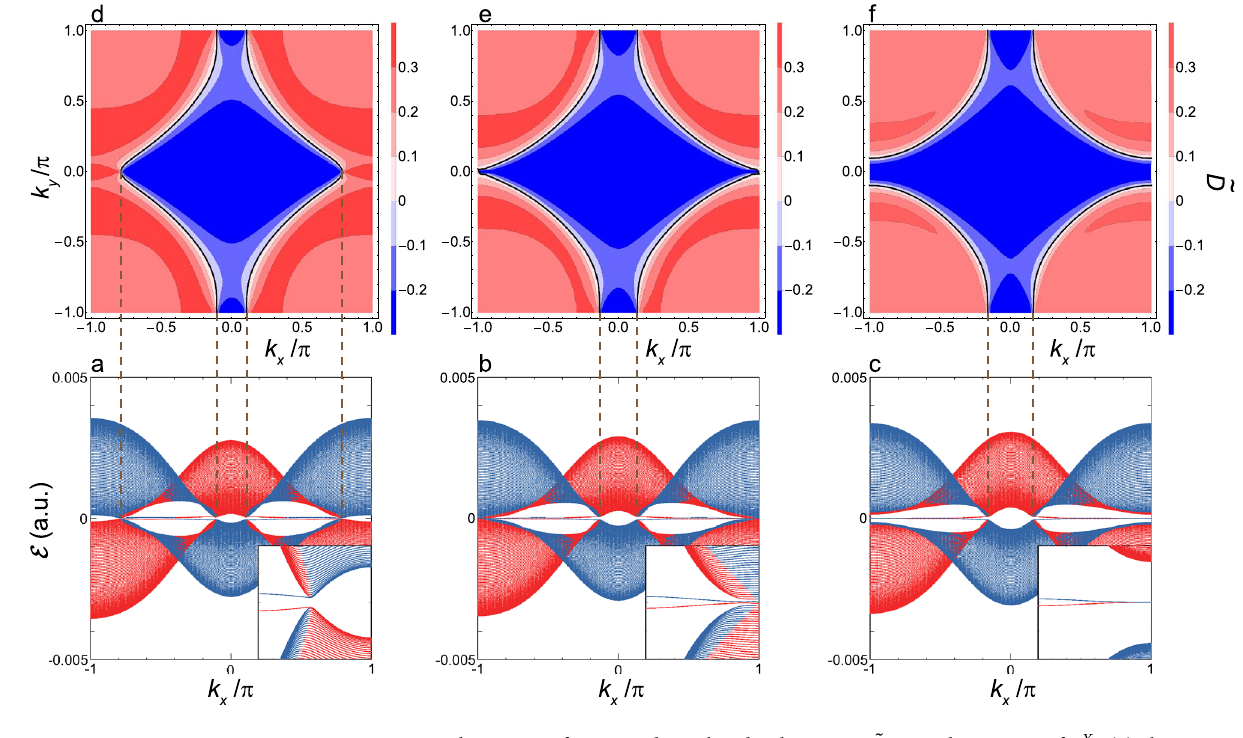
Figure 6. Quasienergy dispersion of E ( k x ) and interband polarization ˜ D ( k ) in the vicinity of F X 1 x . ( a ) Shown are E p ( 1 ) ( k x ) and E s ( − 1 ) ( k x ) as functions of k x at F x = 1.89 × 10 − 4 ( 974 kV/cm ) ( F X 1 x < F x < F X 2 x ) . The two quasienergy bands p (1) and s ( − 1 ) are shown by red and blue lines, respectively. Inset: the expanded view of these two bands in the vicinity of the ¯ X 1 -point. ( b ) The same as the ( a ) but at F X 1 x = 1.80 × 10 − 4 ( 927 kV/cm ) . ( c ) The same as the ( a ) but at F x = 1.69 × 10 − 4 ( 871kV/cm ) ( F x < F X 1 x ) . ( d ) Shown is a contour map ˜ D ( k ) in the ( k x , k y ) -plane at F x given by ( a ). The vertical dashed lines show the projection of ˜ D ( k ) = 0 (the zero contour) onto the k x -axis shown in the ( a ). ( e ) The same as the ( d ) but at F X 1 x and with the zero contour projected onto the k x -axis shown in the ( b ). ( f ) The same as the ( d ) but at F x given by ( c ) and with the zero contour projected onto the k x -axis shown in the ( c ).